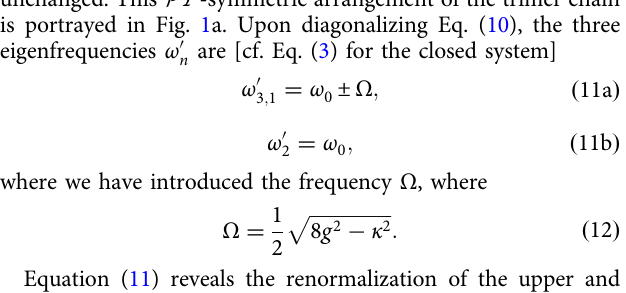
and ω 0 , as compared to ω 3 and ω 1 in 3 1